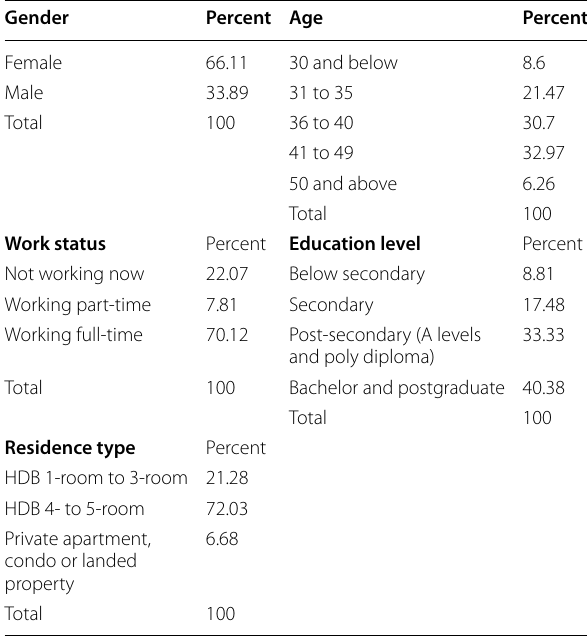
Table 1 Frequency table of gender, age group, work status, education, and residence type